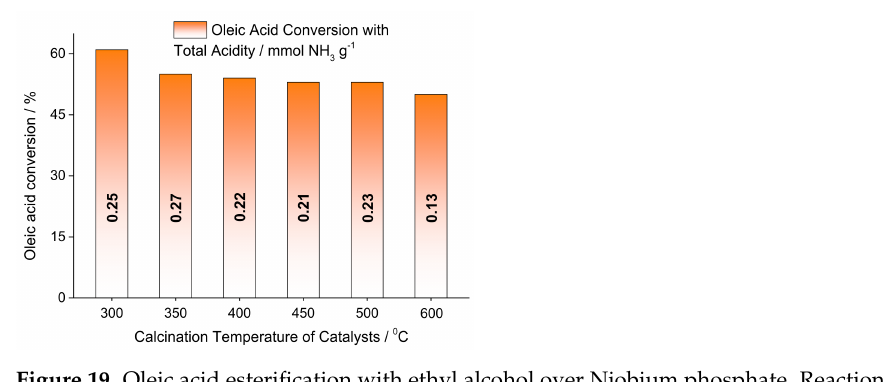
Figure 19. Oleic acid esterification with ethyl alcohol over Niobium phosphate. Reaction conditions: ethyl alcohol: oleic acid molar ratio (6:1), catalyst (0.3 g), temperature (250 ◦ C) (adapted from [71]).